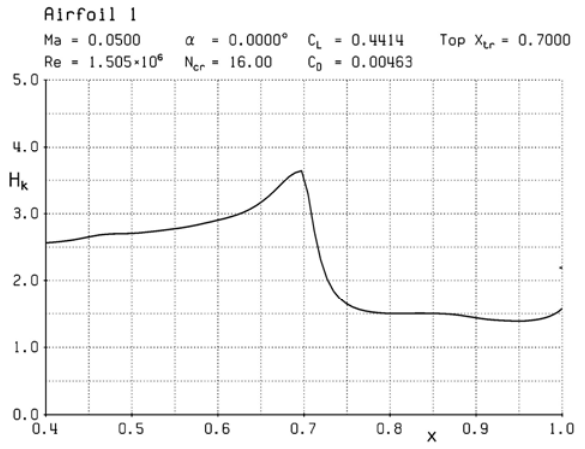
Fig 6 . Calculated (MSES) shape parameter H K on the upper side of airfoil 1 versus chord position at a = 0